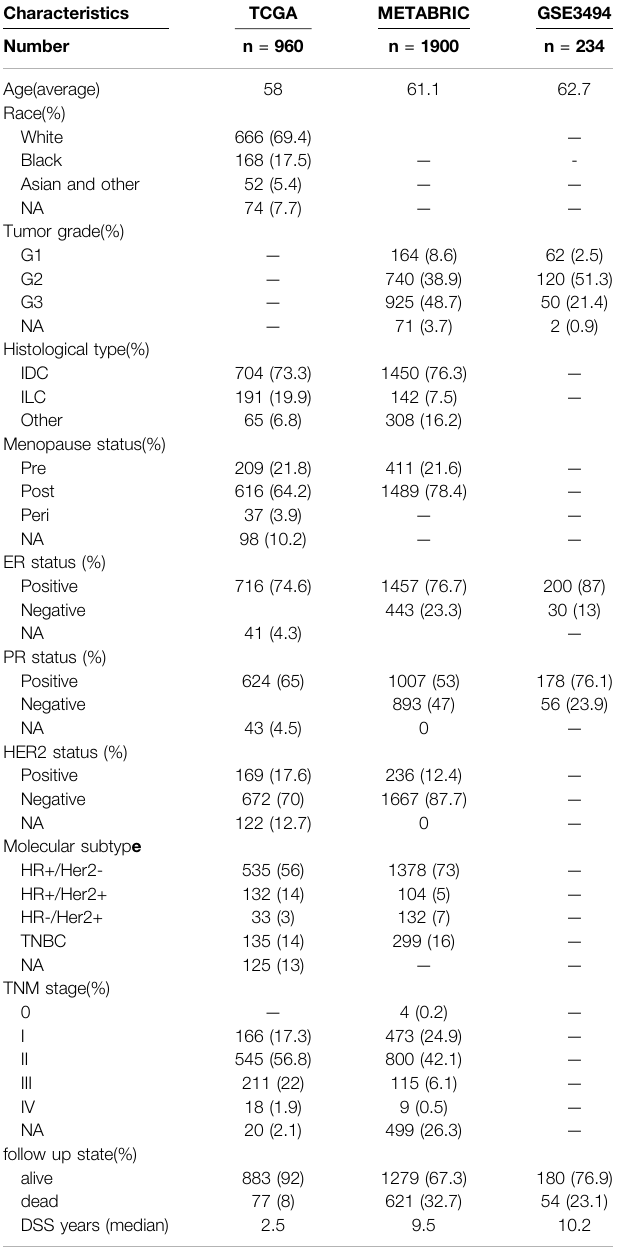
TABLE 1| ThebaselinefeaturesoftheTCGA,METABRICand GSE3494cohorts.